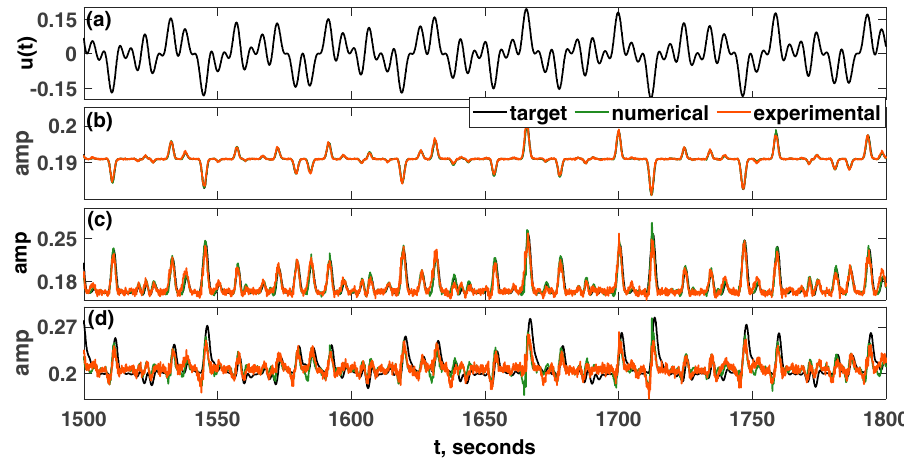
7 6 , NMSE sim = 7.8199 × 10 − . ( c ) 4 . ( d ) 20th order NARMA task.